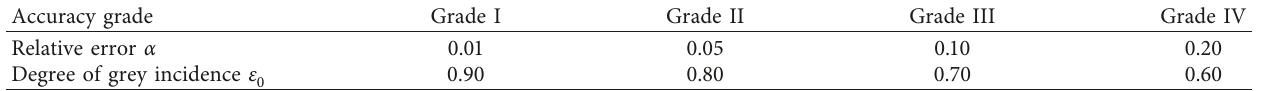
Table 3: Reference table for accuracy test grade.